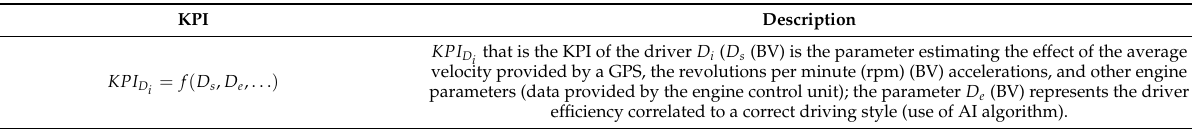
Table A1. KPIs in “Energy logistics” (BV means basic values, BK means basic KPI, CK means complex KPI as a function of BV and BK) .